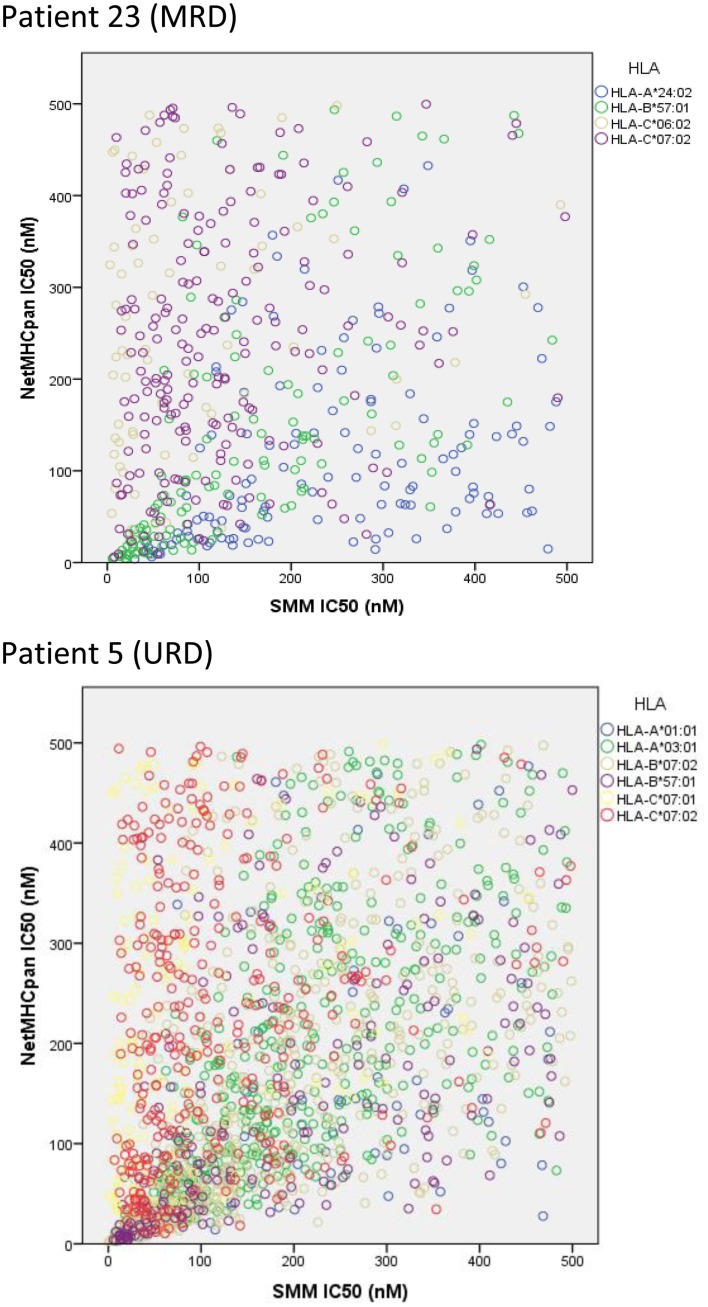
Unique peptide-HLA complexes (GVH vector) with IC50 < 500 nM predicted by both SMM and NetMHCpan. Scatter plots depict the IC50 for unique polymorphic peptide-HLA complexes predicted by the two different algorithms studied. Each circle corresponds to a unique peptide-HLA complex, with color depicting specific HLA. A large number of patient-HLA-specific strong-binding peptides identified by both programs, using SNP data derived from exome sequencing. Only shared peptide-HLA complexes predicted to have an IC50 < 500 nM by both algorithms included.